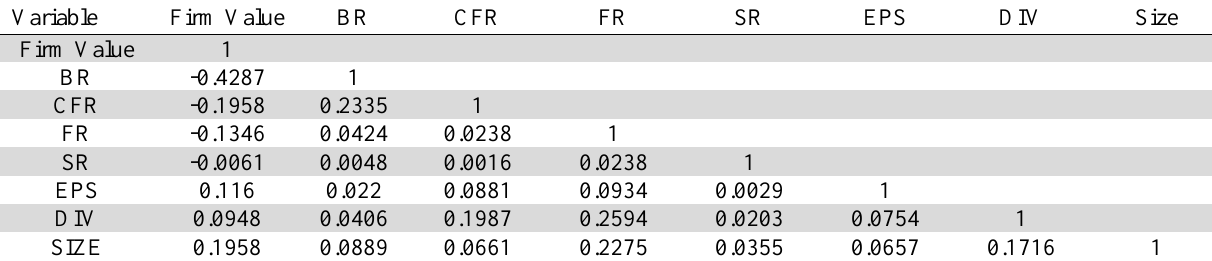
The summary of correlation among various pairs of independent variables